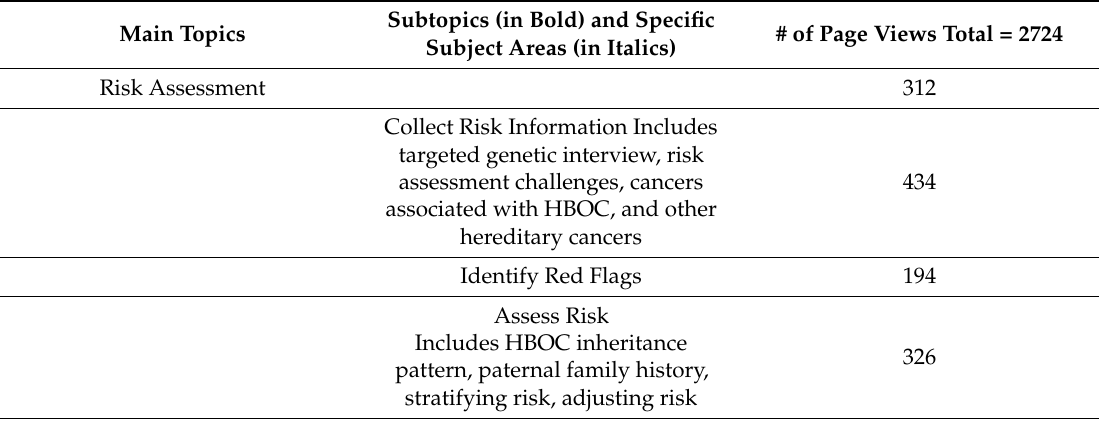
Table 3. Number of webpage views by main topics and subtopics